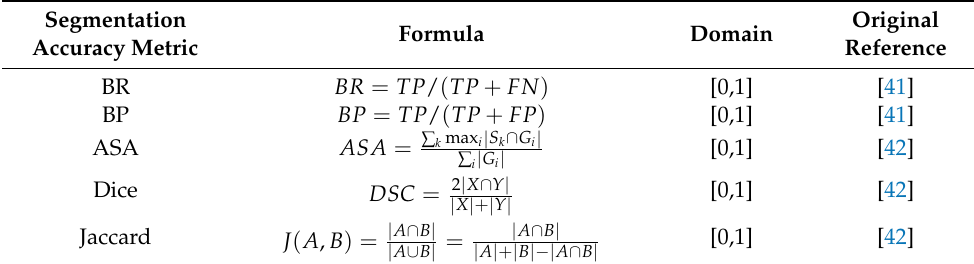
Table 1. Common evaluation criteria of image